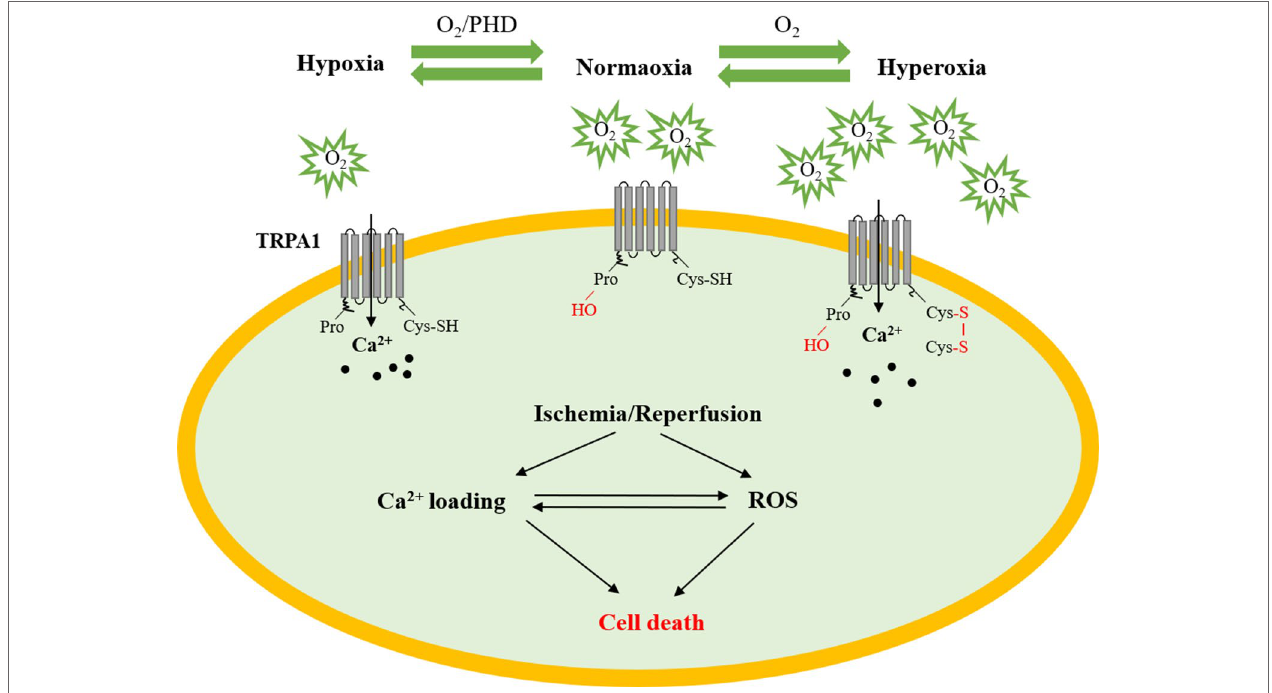
FIGURE 2 | The role of TRPA1 in myocardial ischemia–reperfusion injury. Under normoxic conditions, PHDs inhibit TRPA1 channel activity. Under hyperoxic conditions,